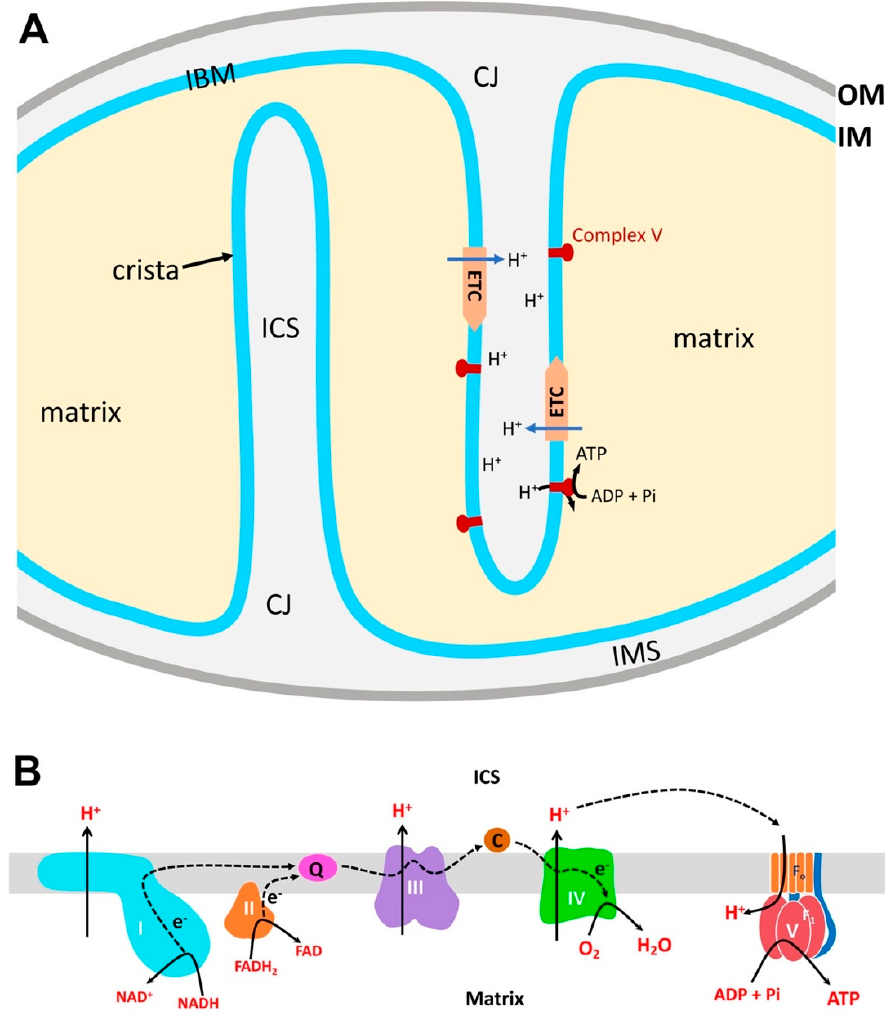
Figure 1. Mitochondrial compartments and electron transport chain (ETC). ( A ) OM, outer membrane; IM, inner membrane; IMS, intermembrane space; IBM, inner boundary membrane; ICS, intra-cristal space; CJ, cristae junction. In matrix, the reducing equivalents are generated from substrate oxidation (TCA cycle, fatty acid oxidation, and other metabolisms) and donate electrons to ETC for proton translocation to ICS. Re-entering of protons to the matrix through complex V drives ATP synthesis. ( B ) Electron flow in the ETC. Coenzyme Q (Q) and cytochrome c (C) are mobile electron carriers. 3. Proteins and Lipids for Mitochondrial Membrane Remodeling